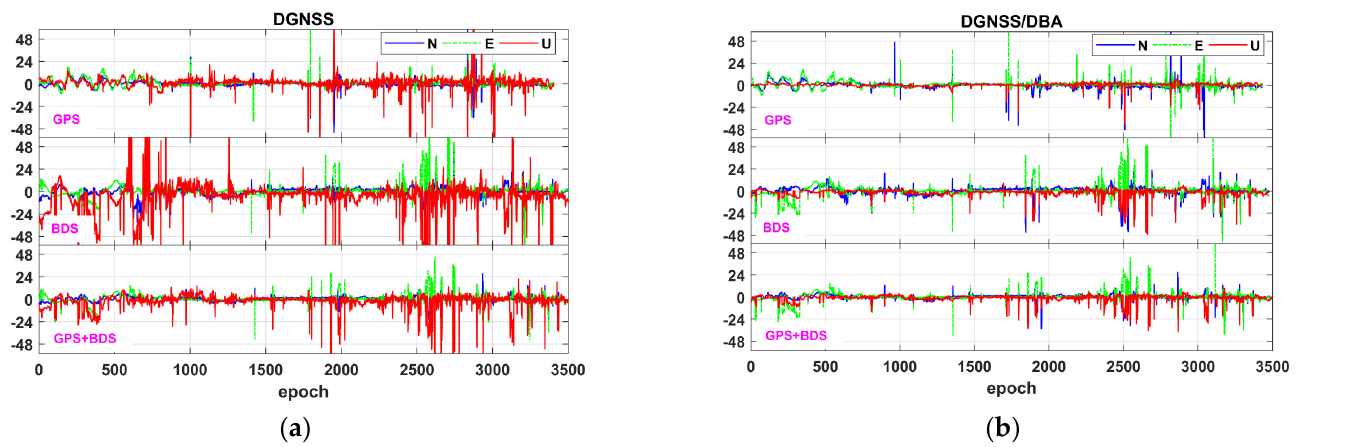
Figure 19. The deviation sequence of low − cost NEO − M8T receiver in the N/E/U directions during the kinematic vehicle experiment in the complex urban environment: ( a ) DGNSS positioning mode; ( b ) DGNSS/DBA positioning mode.